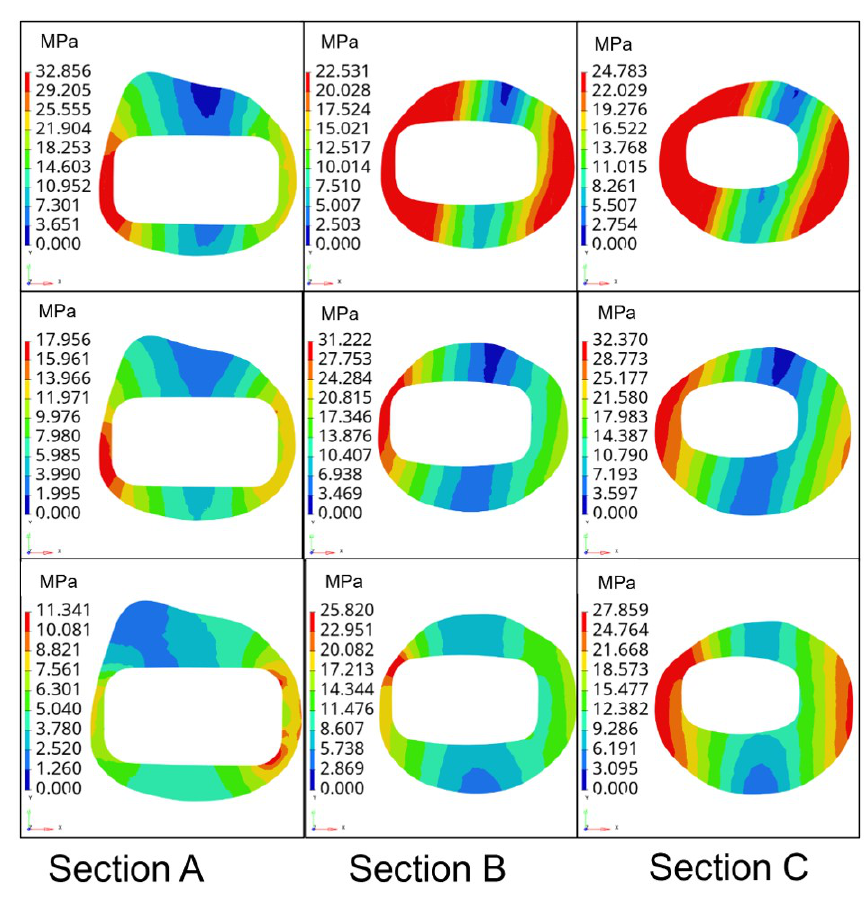
Figure 8. Stress nephogram distribution of prototype femur stem cross section. The division of three sections of the femur and the average stress values of sections under three conditions are shown in Table 2 and Figure 10. Table 2. Average cross-section stress values under different conditions